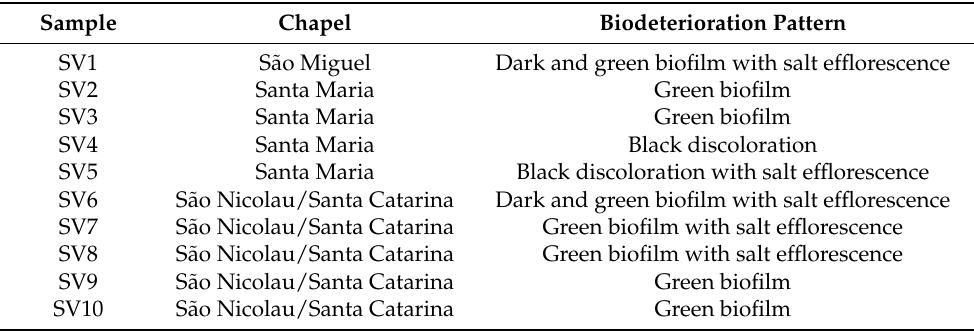
Table 1. Sample description: chapel of origin and biodeterioration pattern description.